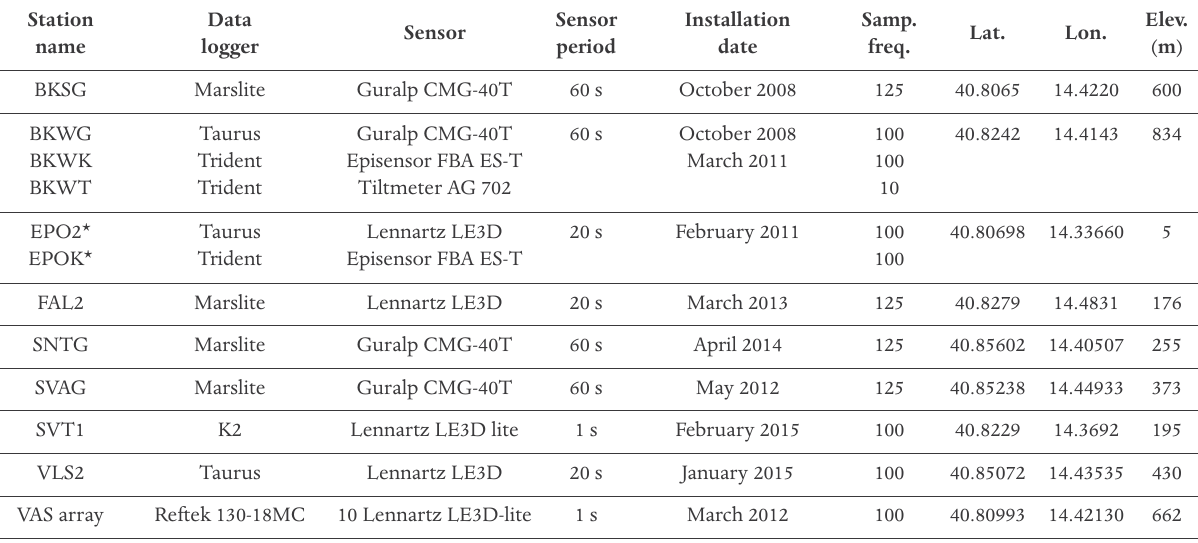
Table 2. Vesuvius stand-alone seismic network (August 2015). Notes: (*) EPO2 and EPOK were dismissed in January 2015 because replaced by a real time station (VEPO).